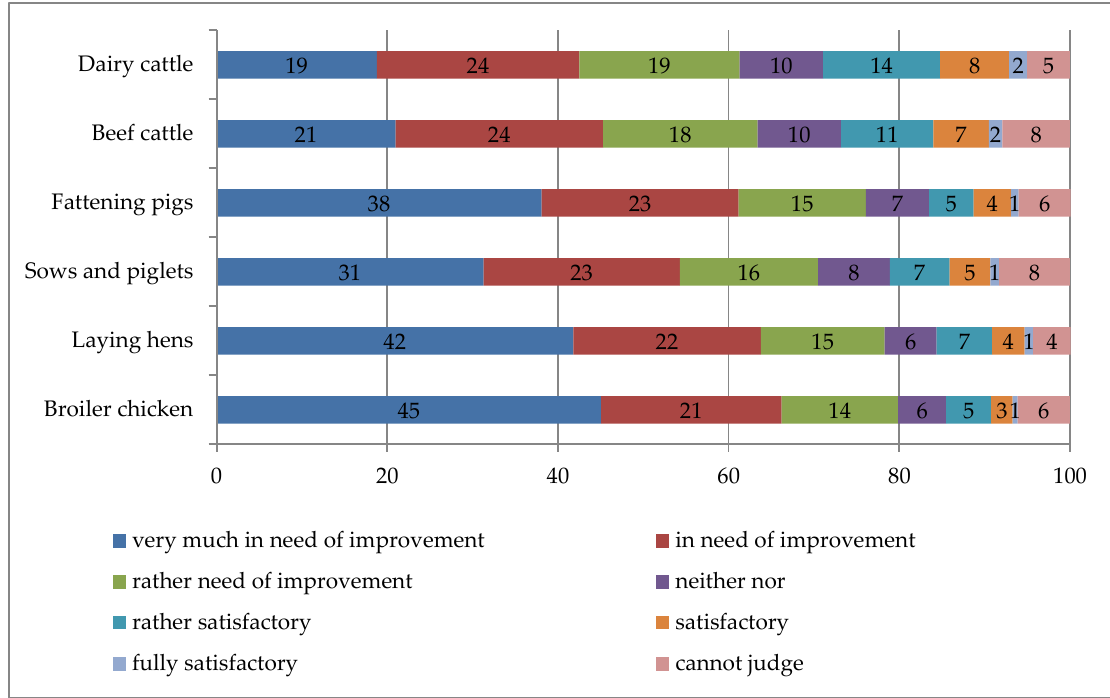
Figure 1. Respondents ′ assessment of different types of livestock farming.